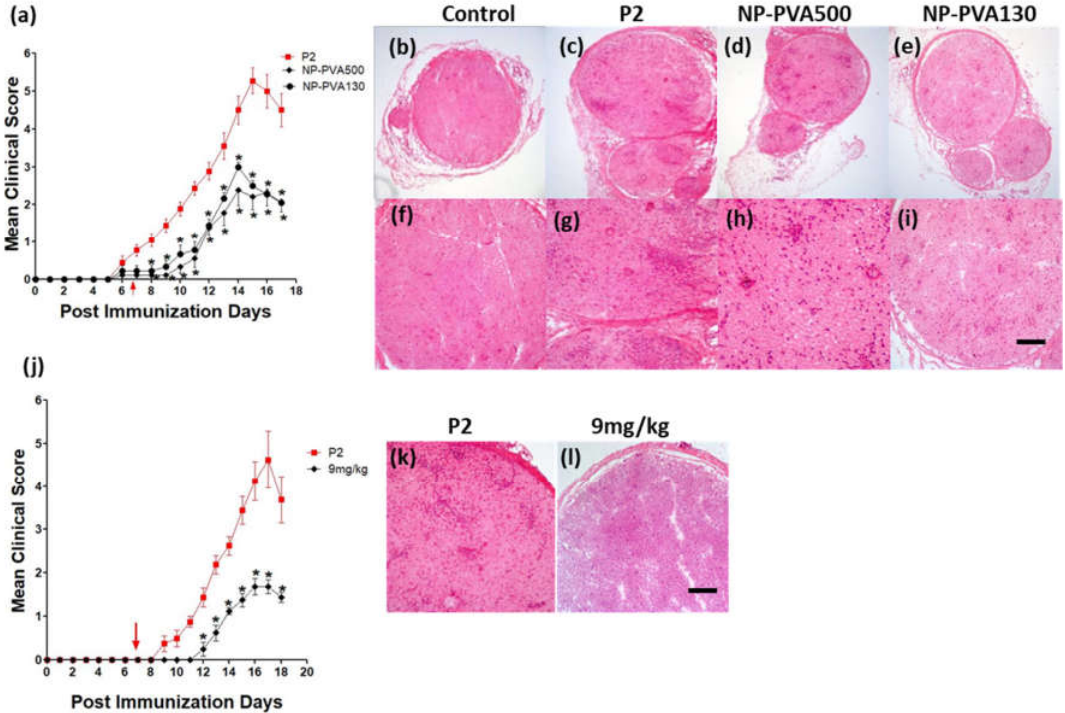
Figure 2. Treatment with different sizes of NPs at the early onset of EAN. ( a ) Mean clinical scores (± S.E.M.) post-immunization with P2-peptide ( n = 9) and treatment with different sizes of NPs ( n = 9). An intravenous daily 9 mg/kg dose of both sizes of NPs, NP-PVA500 and NP-PVA130, were administered to treatment group animals at the onset of the disease. ( d , h ) Early-onset treatment with NP-PVA500 diminished the inflammatory response in sciatic nerves of treated rats. ( e , i ) Treatment with NP-PVA130also lowered the extent of inflammatory response in sciatic nerves of treated